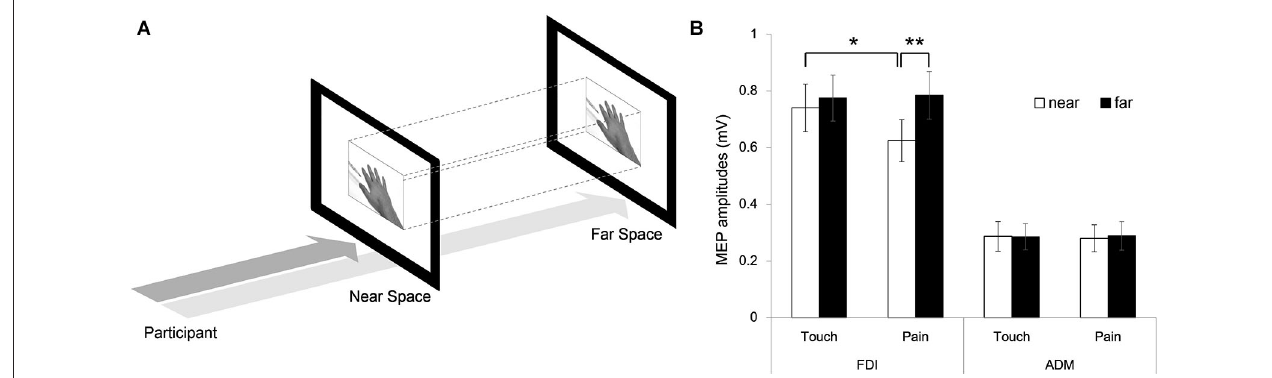
FIGURE 3 | Follow up experiment . (A) Identically sized stimuli were presented in near and far space. (B) MEP amplitudes of the FDI and ADM muscles in the near and far viewing distance conditions (Error bars: SEM, * p < 0.05, ** p < 0.01).